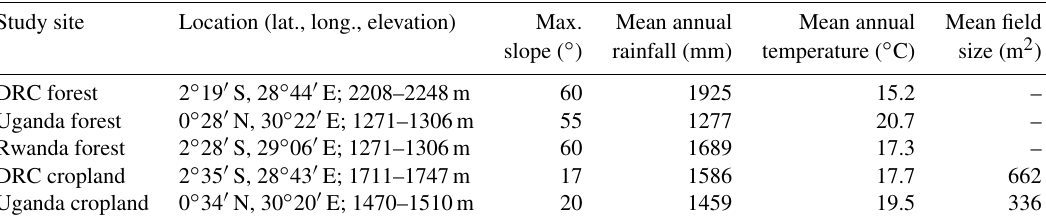
Table 1. Coordinates and main characteristics of investigated study sites. Mean annual rainfall and temperature data are based on Fick and Hijmans (2017).